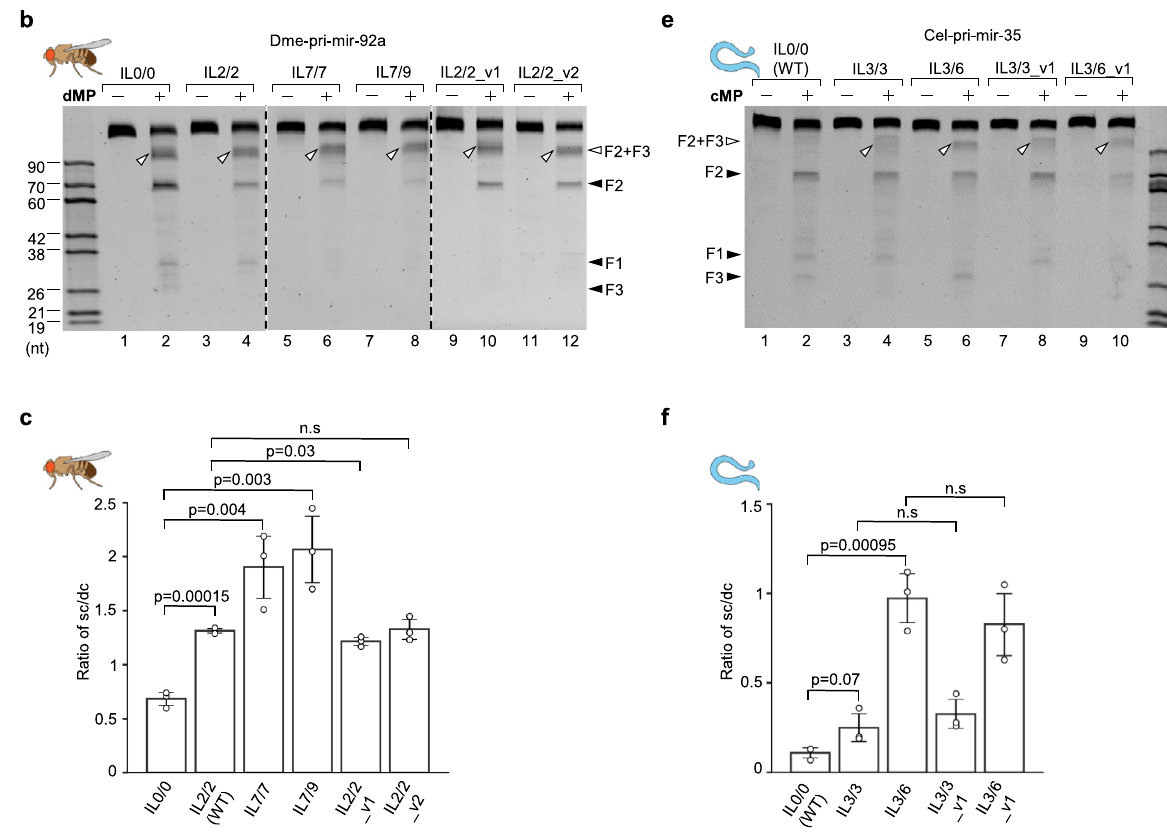
Fig. 3 The ILs stimulate single cleavage of DROSHAs in animals. a , d Diagrams and sequences of pri-miRNAs and their variants. The mutated nt are in red. b , e Pri-miRNA cleavage assays. Three pmol of each pri-miRNA were incubated with 3 μ L of Microprocessor-bound IgG beads for 2 h at 37°C. c , f The sc/dc ratio was calculated as the ratio of the single-cut (F2 + F3) to double-cut product (F2) for three repeated pri-miRNA cleavage results as shown in ( b ) and ( e ). The p -values of the two-tailed t -test for the sc/dc ratios estimated from three replicates were shown. The error bars represent SEM. dMP, D. melanogaster Microprocessor; cMP, C. elegans Microprocessor.